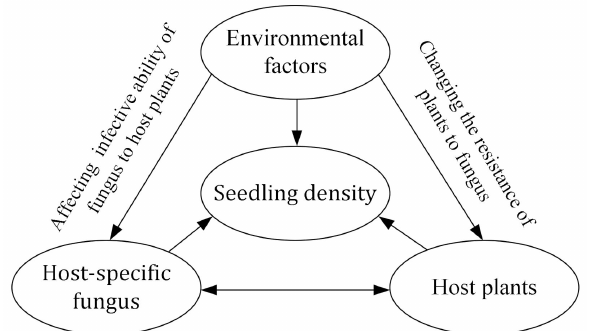
Figure 1. A conceptual framework of the triangular relationship between the host-specific fungus, soil environmental factors, and seedling